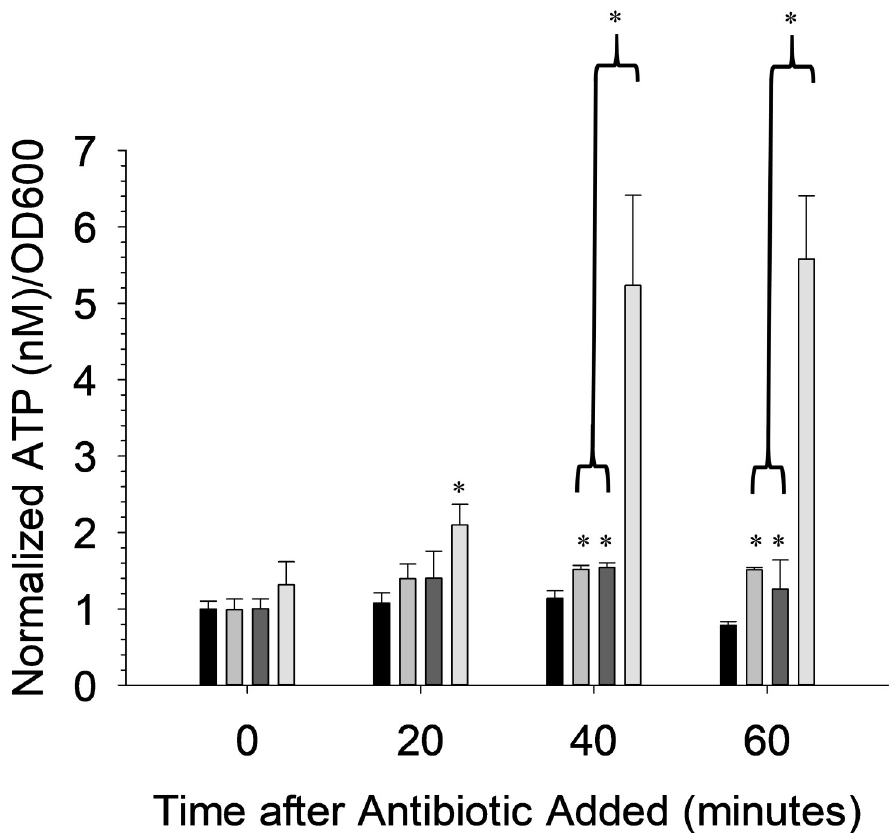
Fig 6. Normalized ATP/OD600 levels showing susceptibility of kanamycin-resistant E . coli and chloramphenicol- resistant B . subitilis mixed culture to bactericidal antibiotics. The bacterial mixed culture was preincubated for 2 hours before adding the antibiotic. Chloramphenicol (5 mg/L) (light gray), kanamycin (50 mg/L) (dark gray), or gentamicin (10 mg/L) (white) were compared against a control containing no antibiotic (black). n = 3; error = standard deviation; � p <